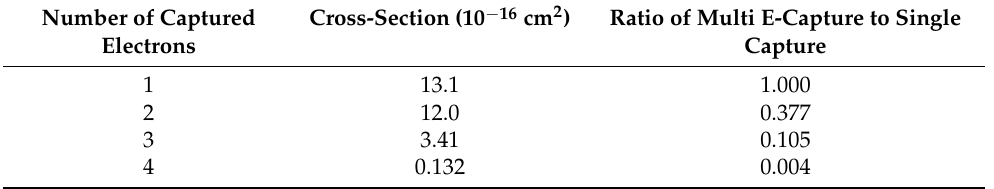
Table 2. The measured cross-section and the calculated ratio of multi to single e-capture for 100 keV C 4+ projectiles. Numerals in square brackets indicate the power of 10. The experimental error in the cross section is